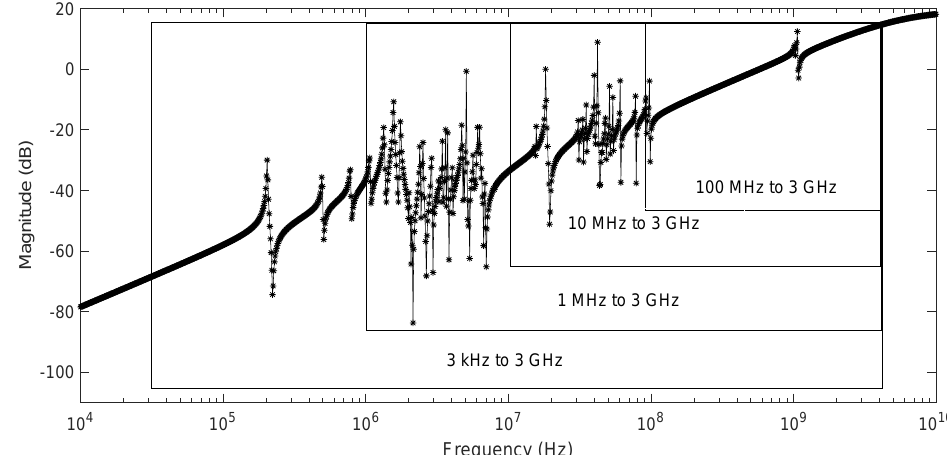
Figure 12. System frequency response of a spiral inductor with original system order of n = 191. The selected spans of frequency now cover different frequency ranges from 3 kHz to 3 GHz.